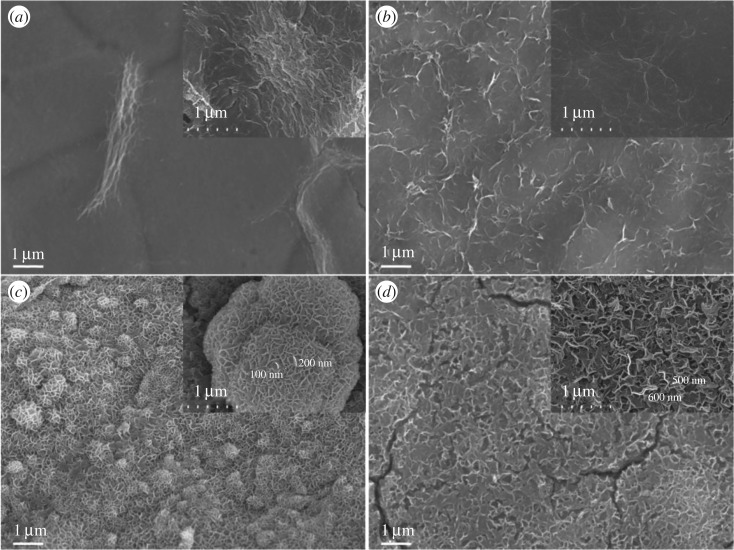
SEM images of Co0.75Ni0.25(OH)2 LDHs: (a) Co0.75Ni0.25(OH)2, (b) Co0.75Ni0.25(OH)2: H, (c) Co0.75Ni0.25(OH)2: D and (d) Co0.75Ni0.25(OH)2: C. Images of higher magnification are shown in respective insets.